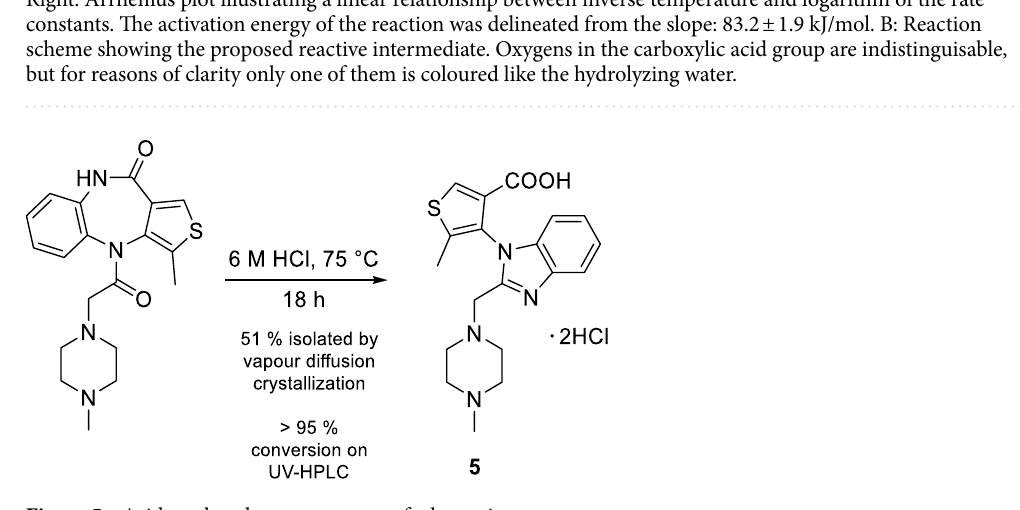
Figure 5. Acid catalyzed rearrangement of